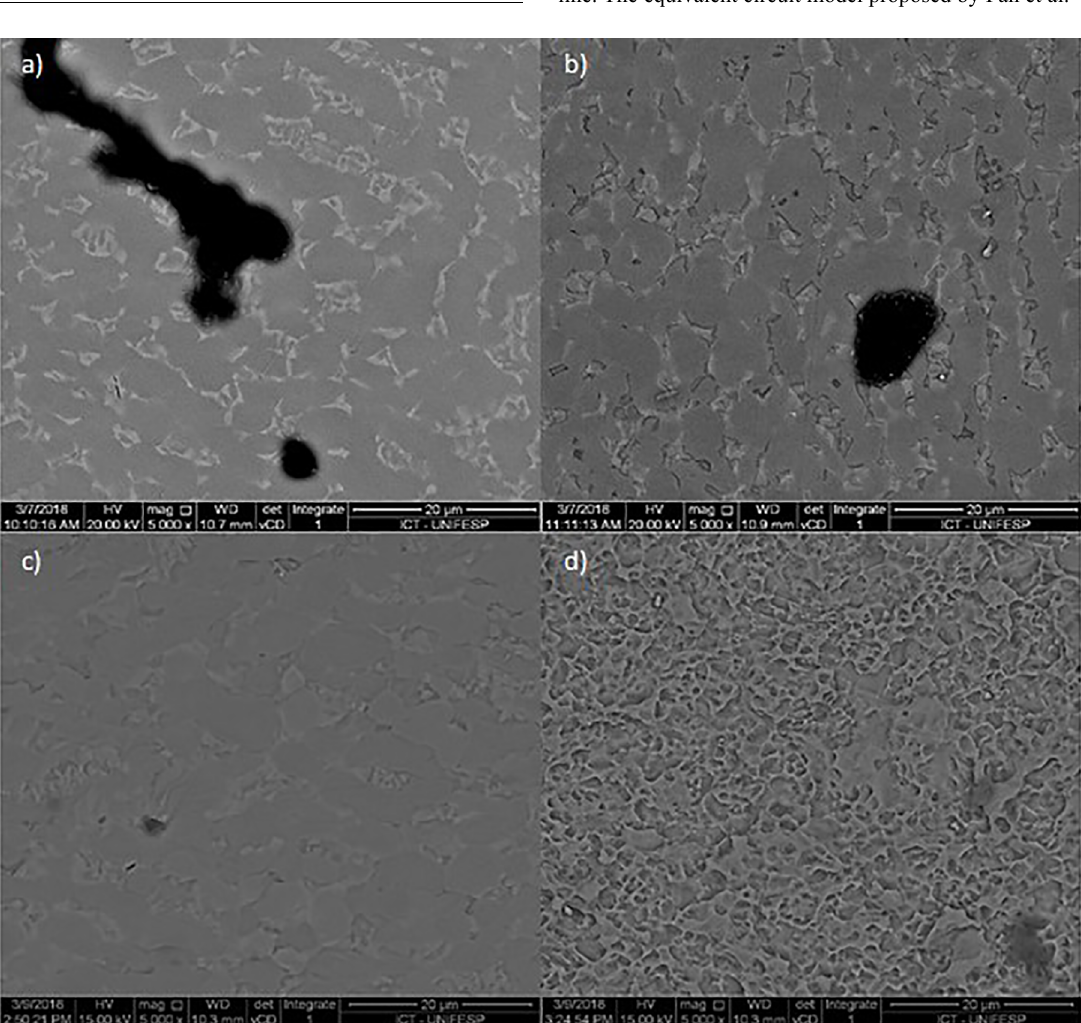
Figure 10 . SEM images of Ti6Al4V samples after potentiodynamic polarization in SBF. (a) untreated control and (b–d) samples etched by piranha solution for 30 min at 25 °C, 40 °C, and 60 °C, respectively.